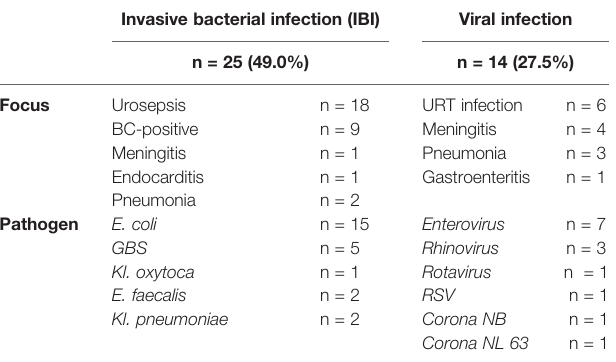
TABLE 2 | Bacterial and viral causes of fever in infants <90 days of age. Invasive bacterial infection